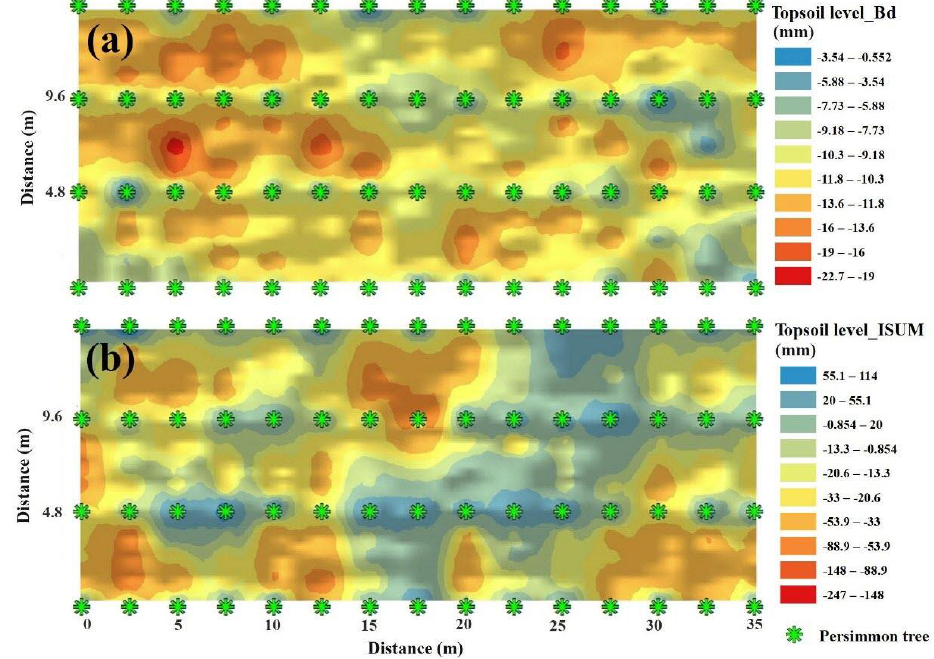
Figure 7. Spatial distribution of topsoil level between 2016 and 2019 estimated using ( a ) Bd and ( b ) ISUM.